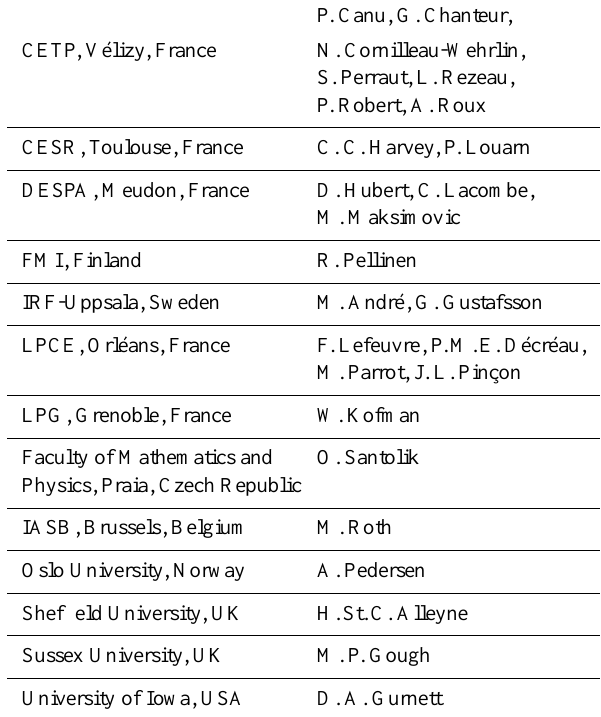
Table 1. STAFF investigator